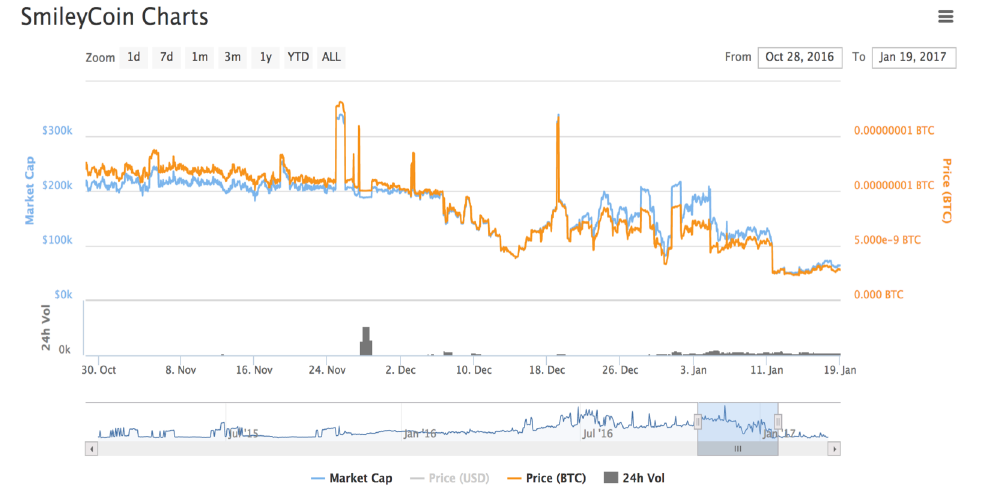
Fig. 6. SMLY price and volume development, around the end of fall semester 2016.